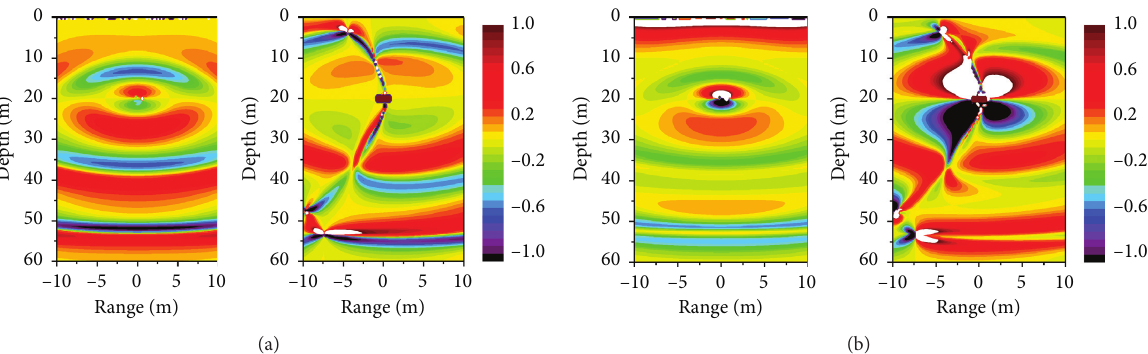
Figure 10: (a) I ∗ z near the source (range from − 10m to 10m. left: point source; right: cylindrical shell) ( f